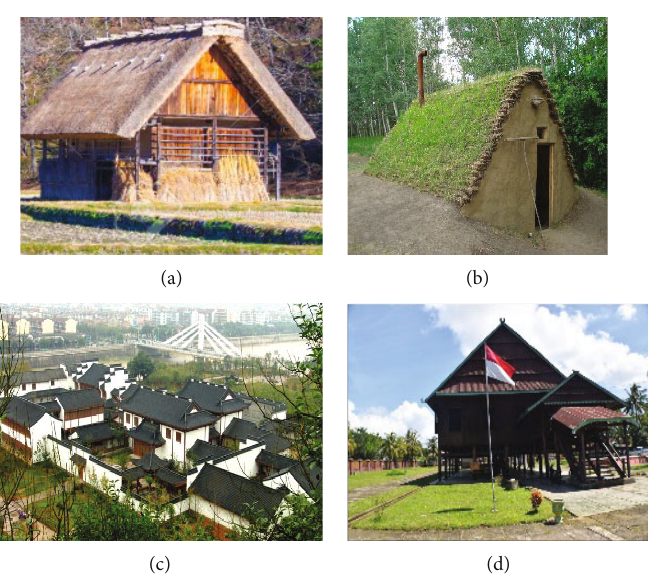
Figure 2: (a) Gassho Zukuri style, Japan [7]; (b) the Burdei, North America [8]; (c) the Siheyuan, China [9]; (d) Bola Soba, Indonesia